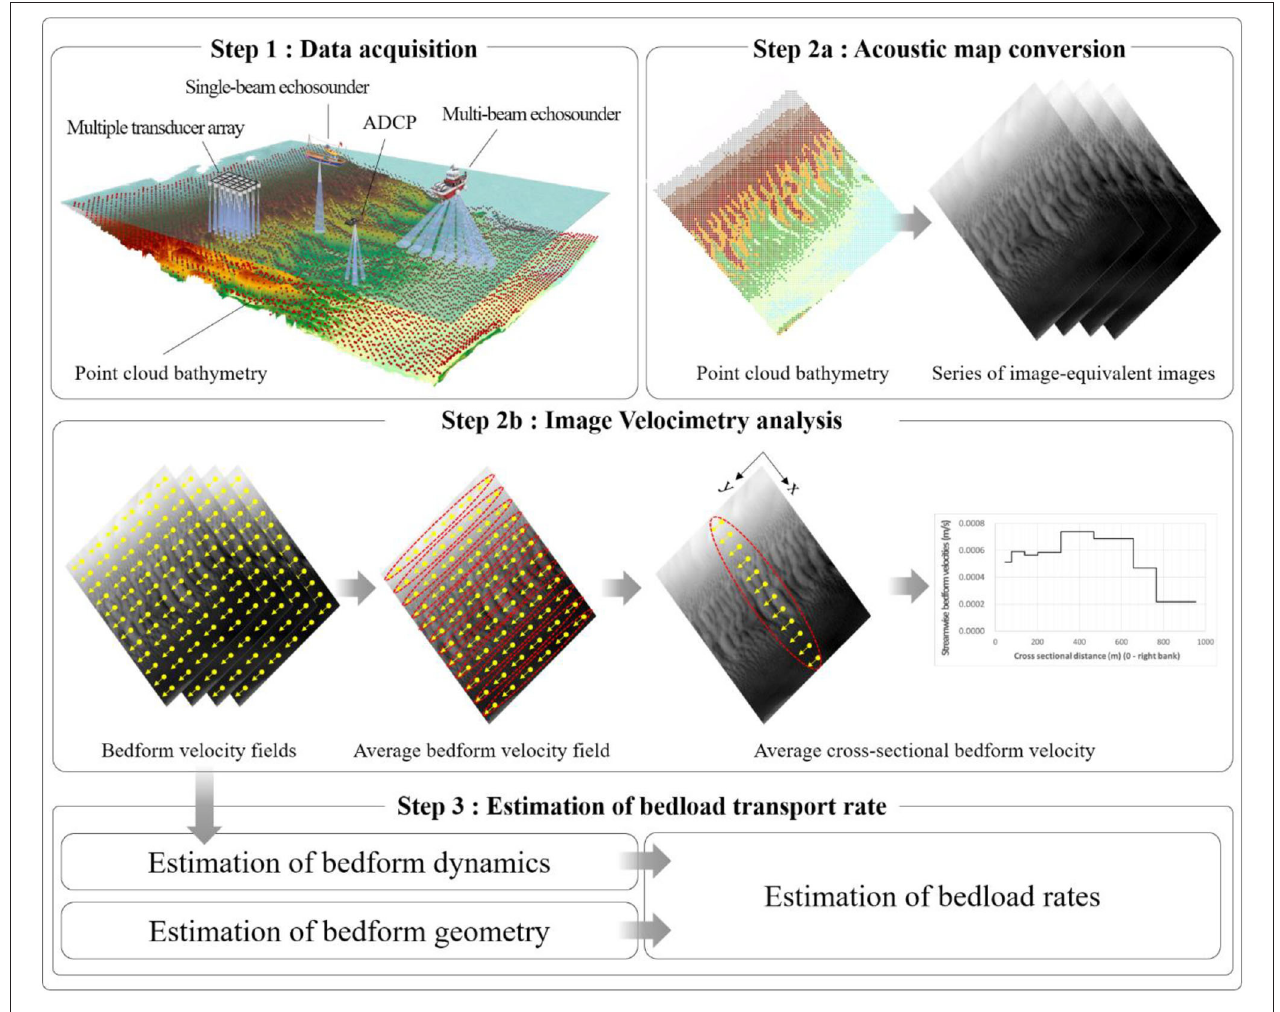
FIGURE 1 | Description of the IV component of AMV